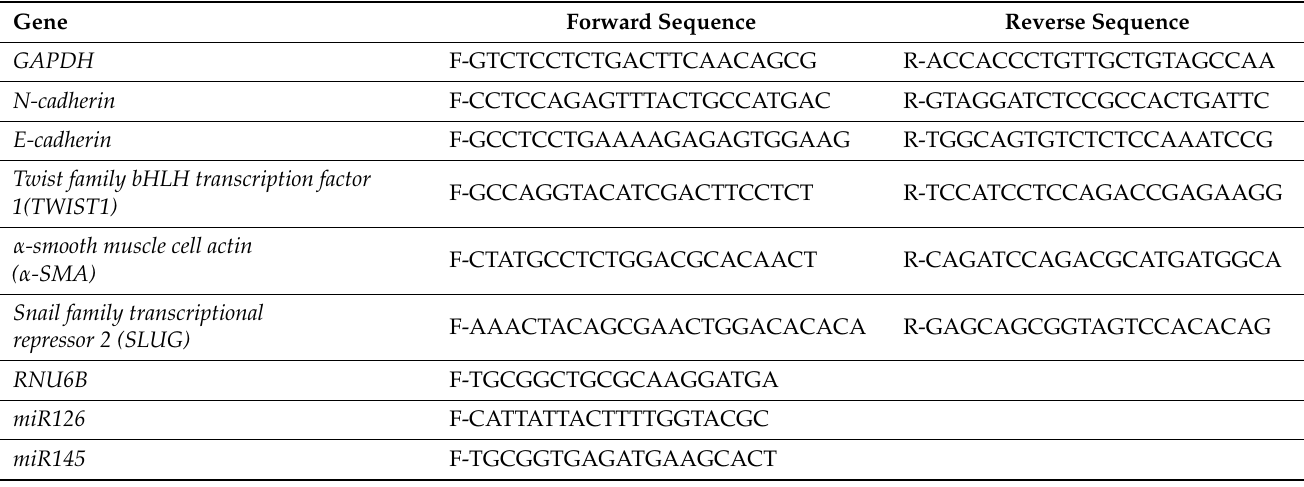
Table 2. Oligonucleotide primers sequences for qRT-PCR